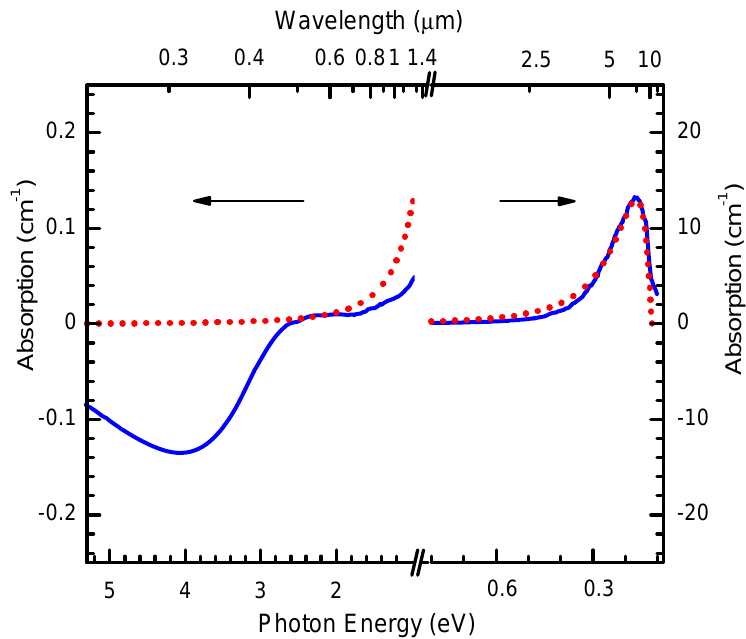
Figure 13. Photoinduced modification of the absorption spectrum of CdF = 4 × 10 17 cm − 3 ) crystal cooled in the dark down to T = 77 K after illumination in the ( N Ga UV-VIS band at the same temperature (solid line). The dotted line shows an approximation of the IR band using the theory of [11].